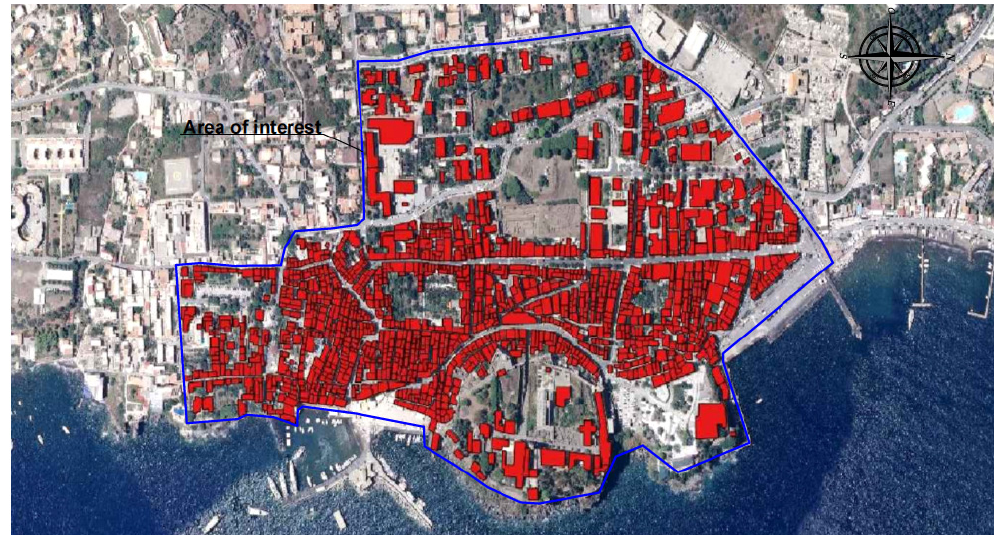
Figure 4. Area under study with identification of the buildings for RWH system installation.